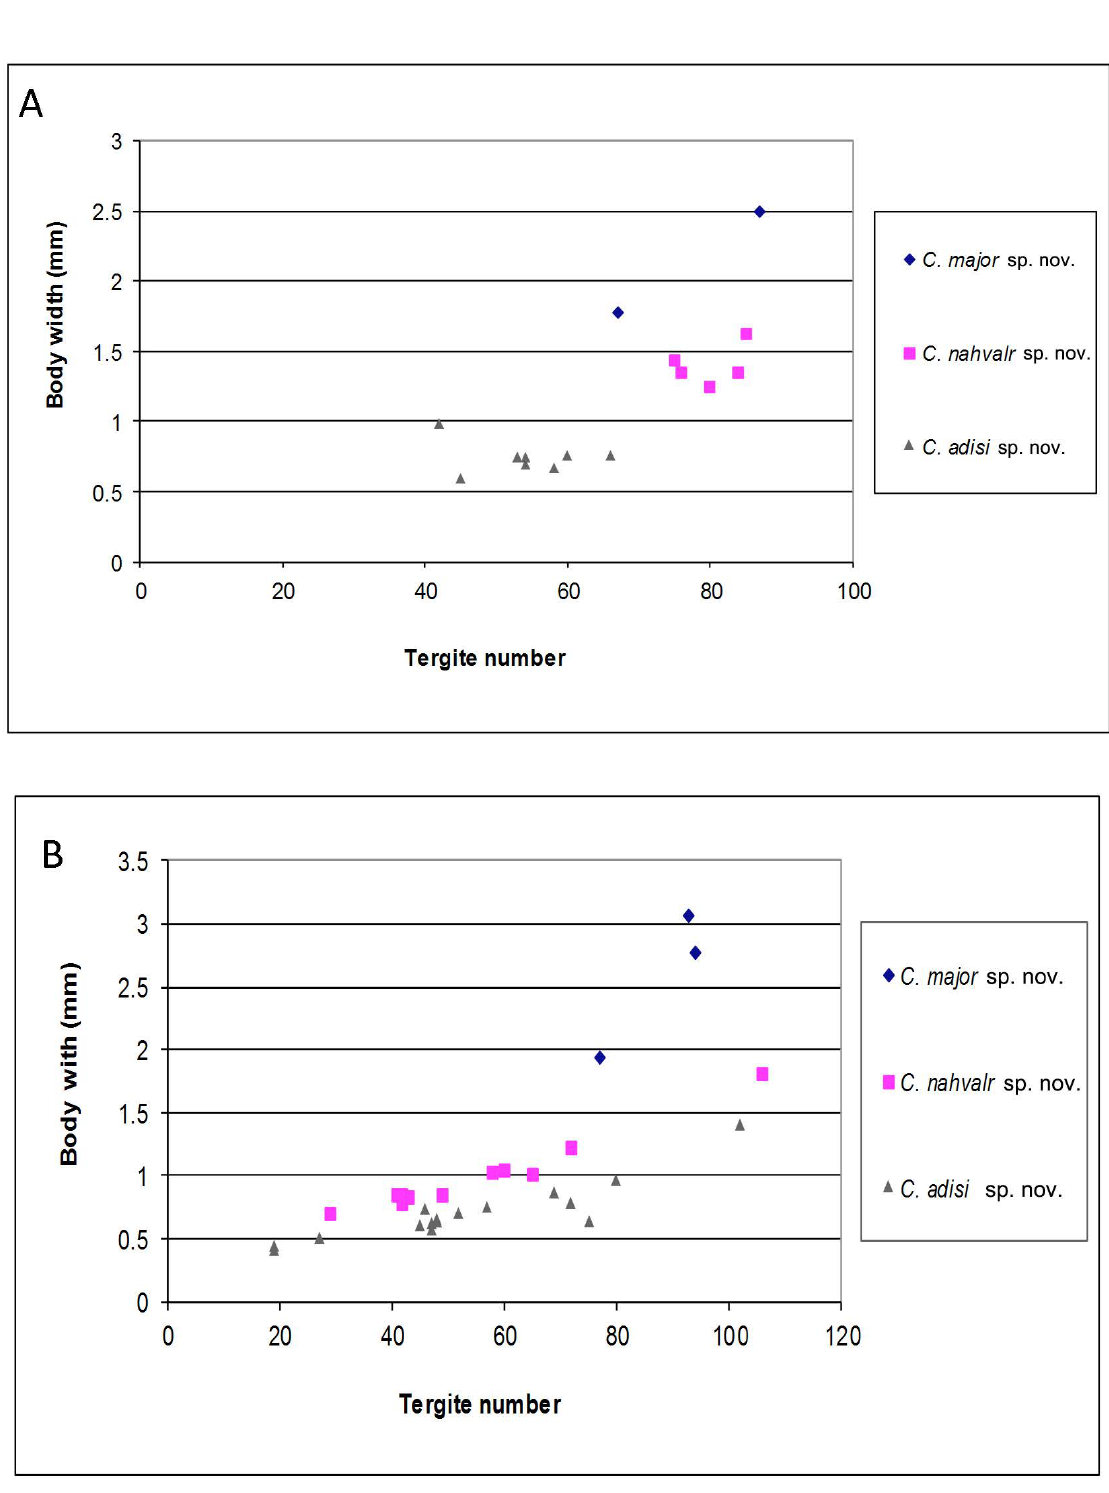
Fig. 1. Body width (mm) against the total number of tergites with legs for new species of Columbianum Verhoeff, 1941. A . Males. B .